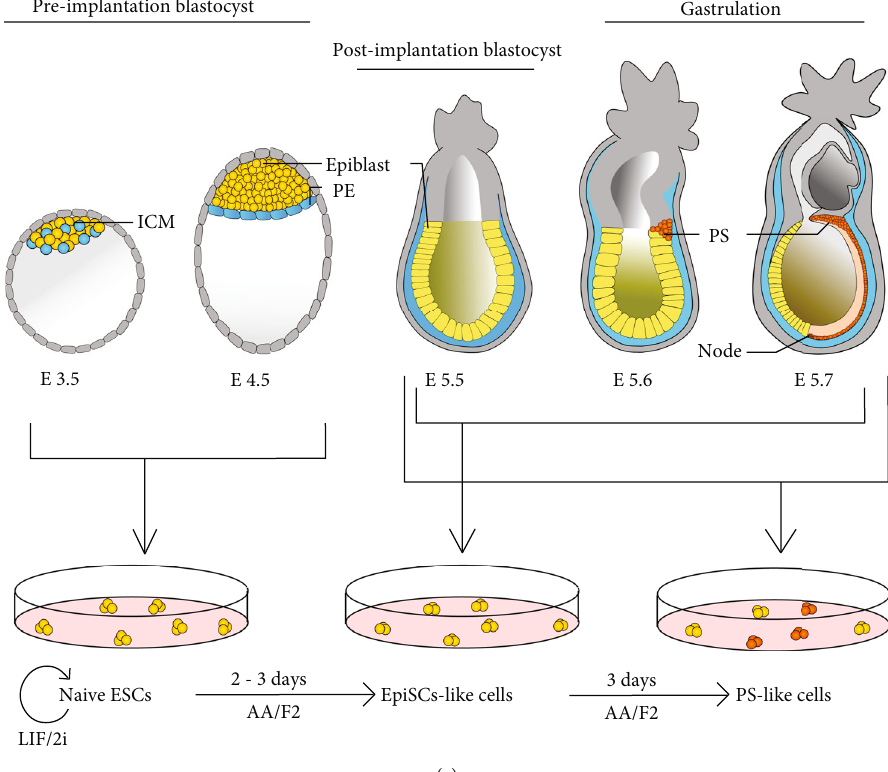
Figure 4: Continuous exposure to the hESC/EpiSC condition draws the PSCs towards posterior mesoderm and endoderm lineages. (a) qRT- PCR analysis of the indicated lineage-speci fi c genes in the indicated samples. Gapdh and Pmm2: housekeeping genes. The endoderm ( Gata6 and Sox17 ) and posterior mesoderm ( Tbx6 and Msgn1 ) markers were induced by 6 days. The neuroectoderm ( Pax6 and Sox1 ), lateral mesoderm ( Foxf1 ), and intermediate mesoderm ( Osr1 ) genes were not expressed. (b) Western blot analysis of the mesoderm (Msgn1 and Tbx6) and endoderm (Sox17) proteins in the cells treated with AA/F2 for the indicated durations. The posterior mesoderm (Msgn1 and Tbx6) and endoderm (Sox17) proteins were expressed by 6 days of the treatment. (c) Flow-cytometric analysis of the fraction of Sox2 +ve and T +ve cells after 3 and 6 days of AA/F2 treatment. Error bars: mean ± SD ( n = 2 ); ∗ p ≤ 0 : 05 and ∗∗ p ≤ 0 : 01 ( p ð Sox2 Þ = 0 : 0070 and p ð T Þ = 0 : 0098 ) (Student ’ s t -test). By 6 days of treatment, the count of Sox2 -expressing cells was very low, and almost half the proportion of the cells expressed the PS marker, T . (d) Analysis of the indicated genes in the FACS-sorted T +ve cells from the AA/F2-6D-treated cells. The T -expressing cells expressed early markers of PS, mesoderm, and endoderm. (e) A model that summarizes the major fi nding of this study. The mESCs were converted to naïve state of pluripotency (represent the pluripotent embryonic cells in the E3.5-E4.5 developmental stages) using the 2i medium (LIF/2i). AA/F2 treatment for 2 to 3 days led these cells to a primed state of pluripotency (may represent the pluripotent epiblast cells in the E5.5-E7.5 developmental stages). This study shows that the continued treatment of AA/F2 for 6 days led